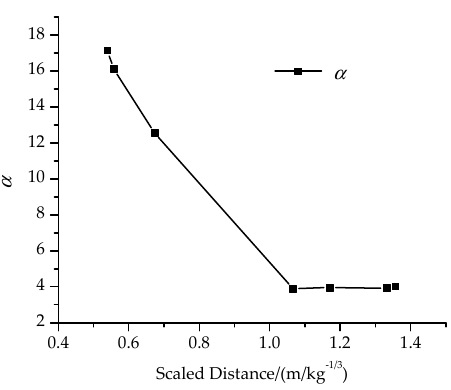
Figure 8. The pressure enhancement factor curve with scaled distance.